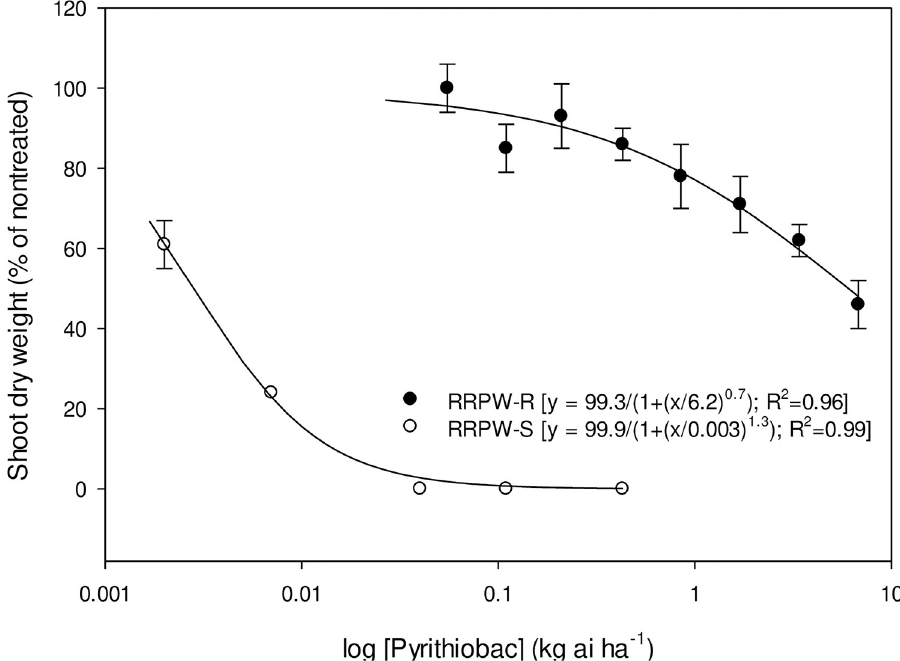
Fig 1. Pyrithiobac dose response on shoot dry weight reduction of ALS-inhibiting herbicide-resistant (RRPW-R) and -susceptible (RRPW-S) Amaranthus retroflexus populations from Mississippi 3 wk after treatment. Vertical bars represent standard error of